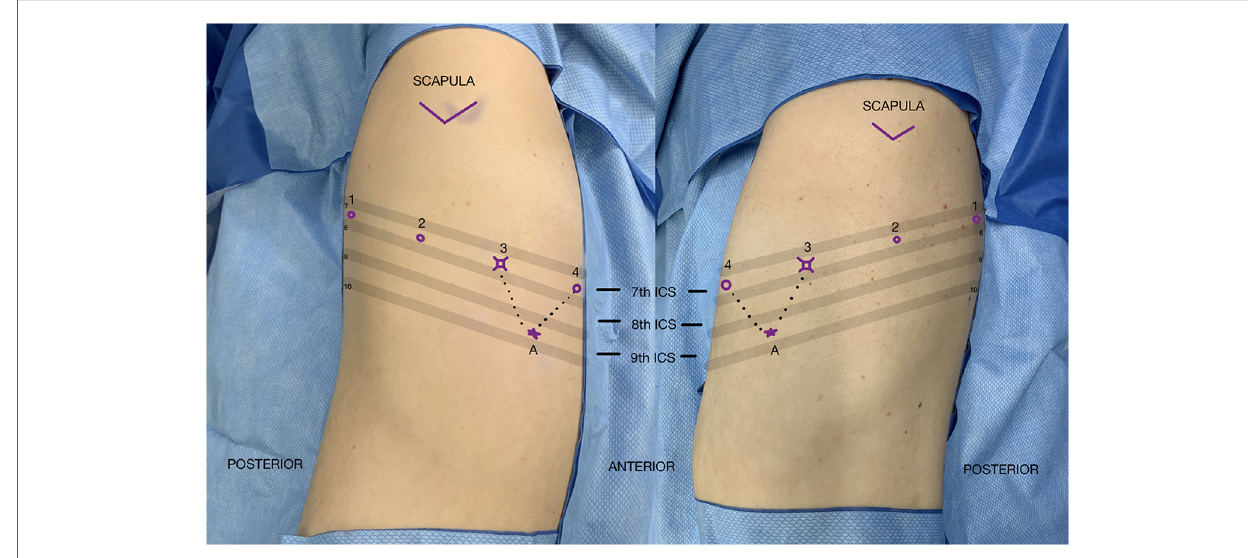
FIGURE 3 Port placement for robotic segmentectomy by elisabeth